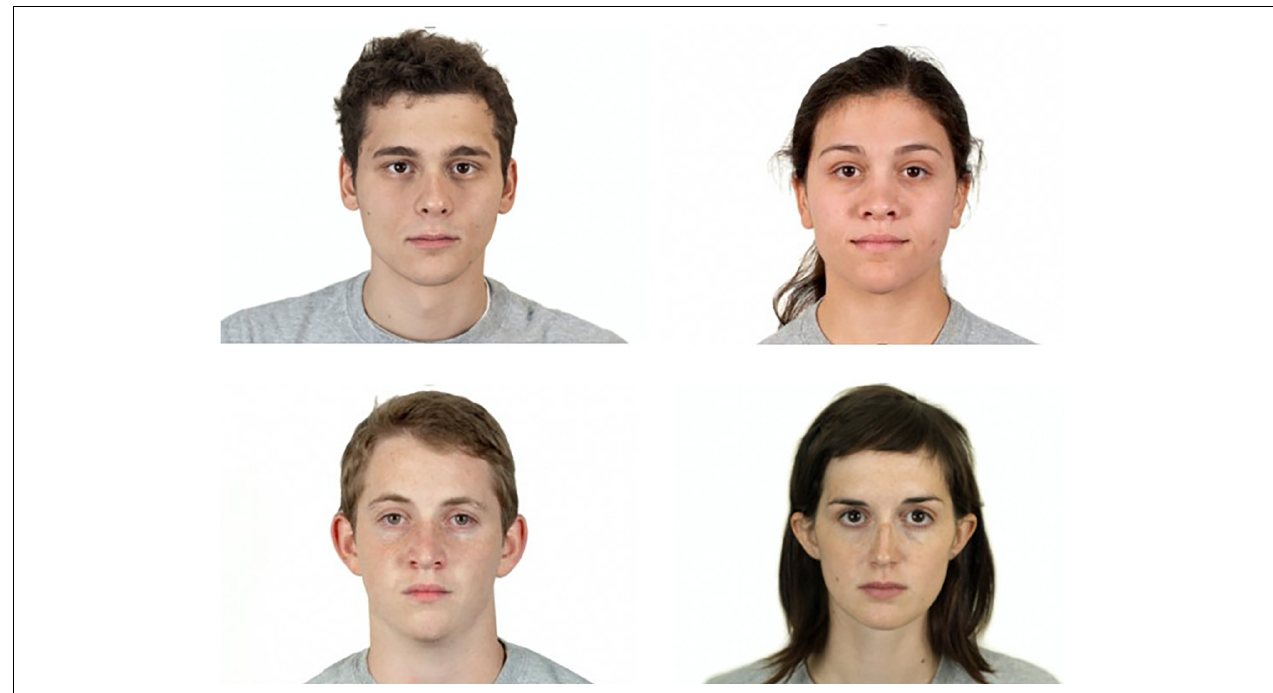
FIGURE 1 | Four of the face stimuli extracted from the Chicago Face Database (Ma et al., 2015) considered in the